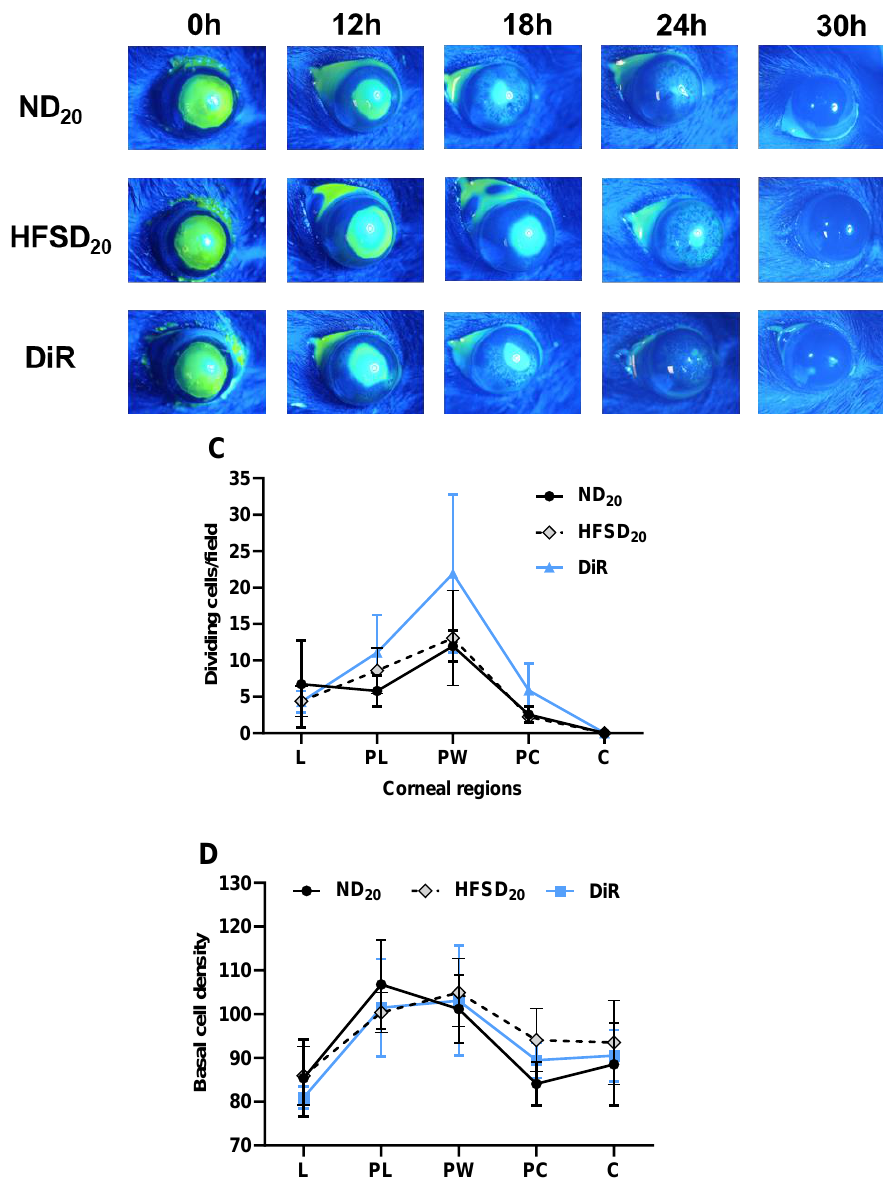
Figure 7. Diet reversal ameliorated impaired corneal wound healing and halted the progression of corneal nerve sensitivity loss observed with high-fat/sucrose consumption. ( A ) Corneal nerve sensitivity in uninjured mice and ( B ) Corneal wound closure Top: Wound closure kinetics. Bottom: Representative images of the epithelial wound at different time points following a 2 mm diameter corneal epithelial abrasion wound. ( C ) Left: Dividing basal epithelial cells in each cornea region. Right: Sum of dividing basal epithelial cells in four fields of view of the cornea (periphery, parawound, paracentral and center) and ( D ) Basal epithelial cell density in each cornea region in mice fed only the normal diet, only the high-fat/sucrose diet, and the diet reversal mice at 30 h post wounding. Data expressed as means ± SD; ND 20 —20-week normal diet; HFSD 20 —20-week high-fat/sucrose diet; DiR—diet reversal; L—limbus; PL—paralimbus/periphery; PW—parawound; PC—paracentral; C—center * p ≤ 0.05, ** p ≤ 0.01 (normal diet vs. high-fat/sucrose diet); † p ≤ 0.05 and †† p ≤